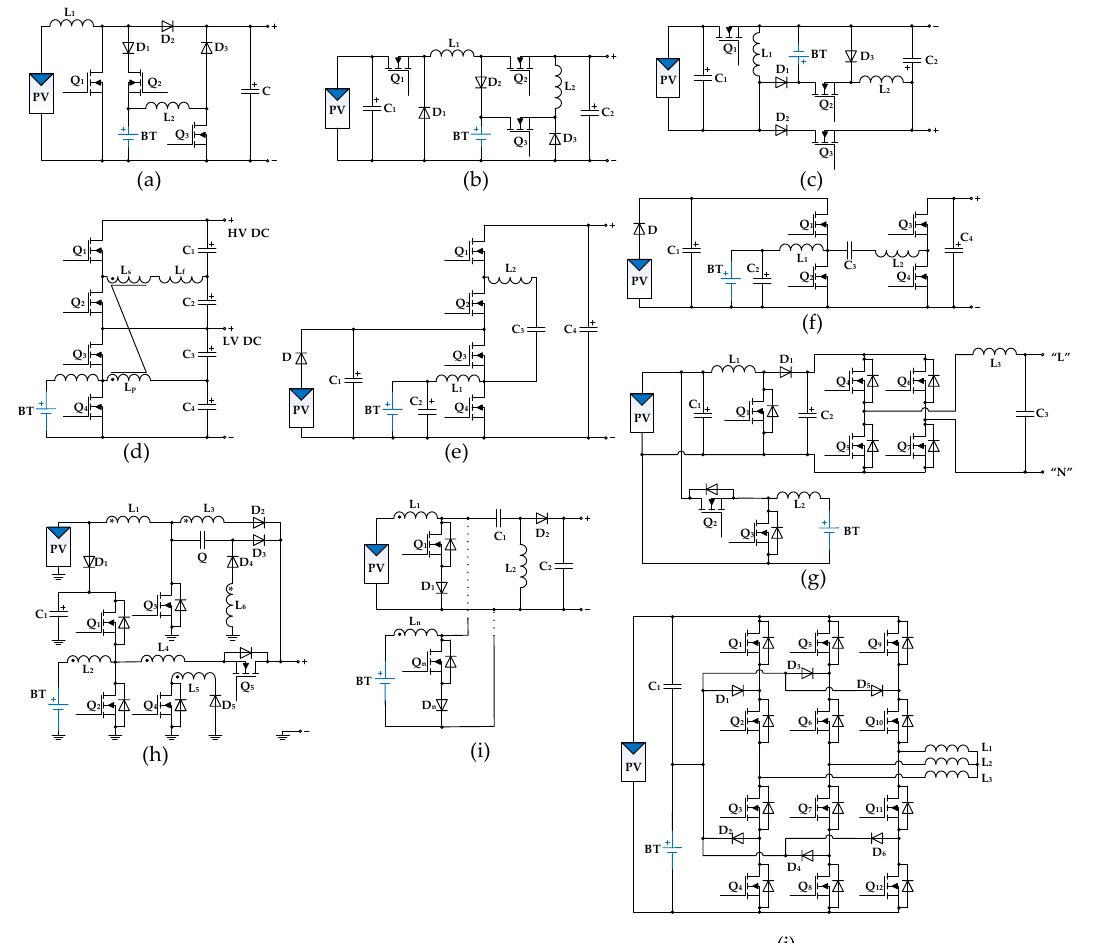
Figure 20. Hybrid converters: ( a ) boost three-port converter; ( b ) buck three-port converter; ( c ) buck- boost three-port converter; ( d ) bidirectional buck-boost converter; ( e ) switched capacitor multi-port converter; ( f ) dual active bridge multi-port converter; ( g ) double-stage with battery boost converter; ( h ) fully soft-switched multi-port DC – DC converter; ( i ) multiple-input SEPIC converter; ( j ) NPC multiport converter.